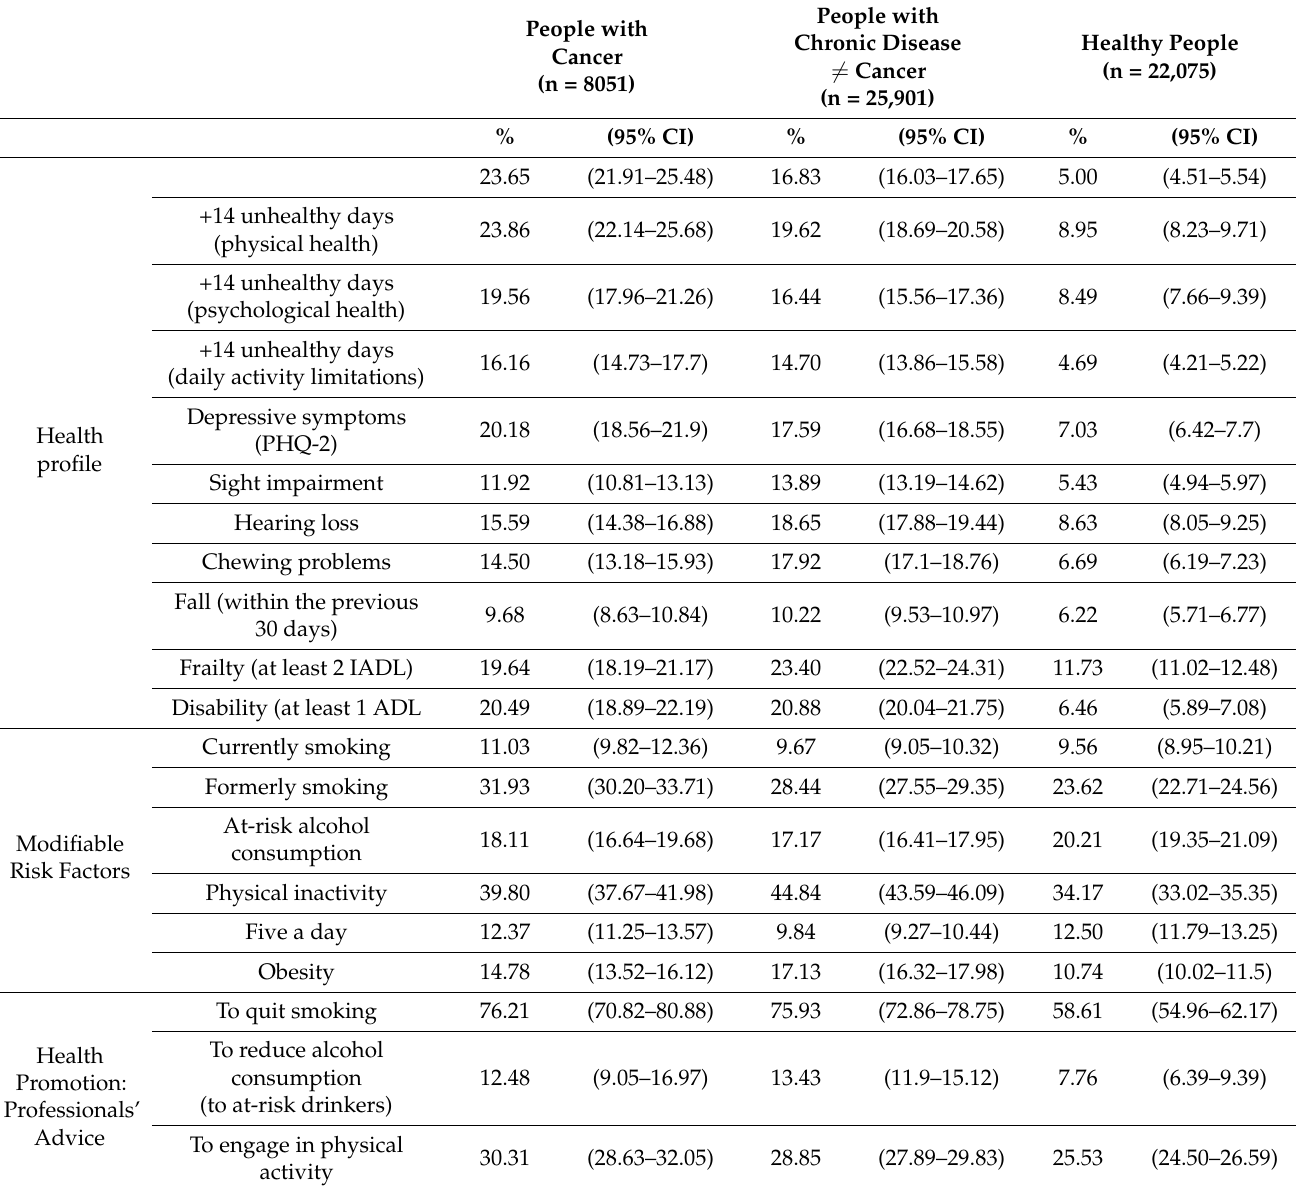
Table 2. Prevalence of health status, preventing profile and social participation indicators among three groups of people aged ≥ 65 years (with cancer, with chronic disease other than cancer, and healthy). Passi d’Argento 2016–2019 (n = 56,027). People with People with Chronic Cancer (n = 8051)